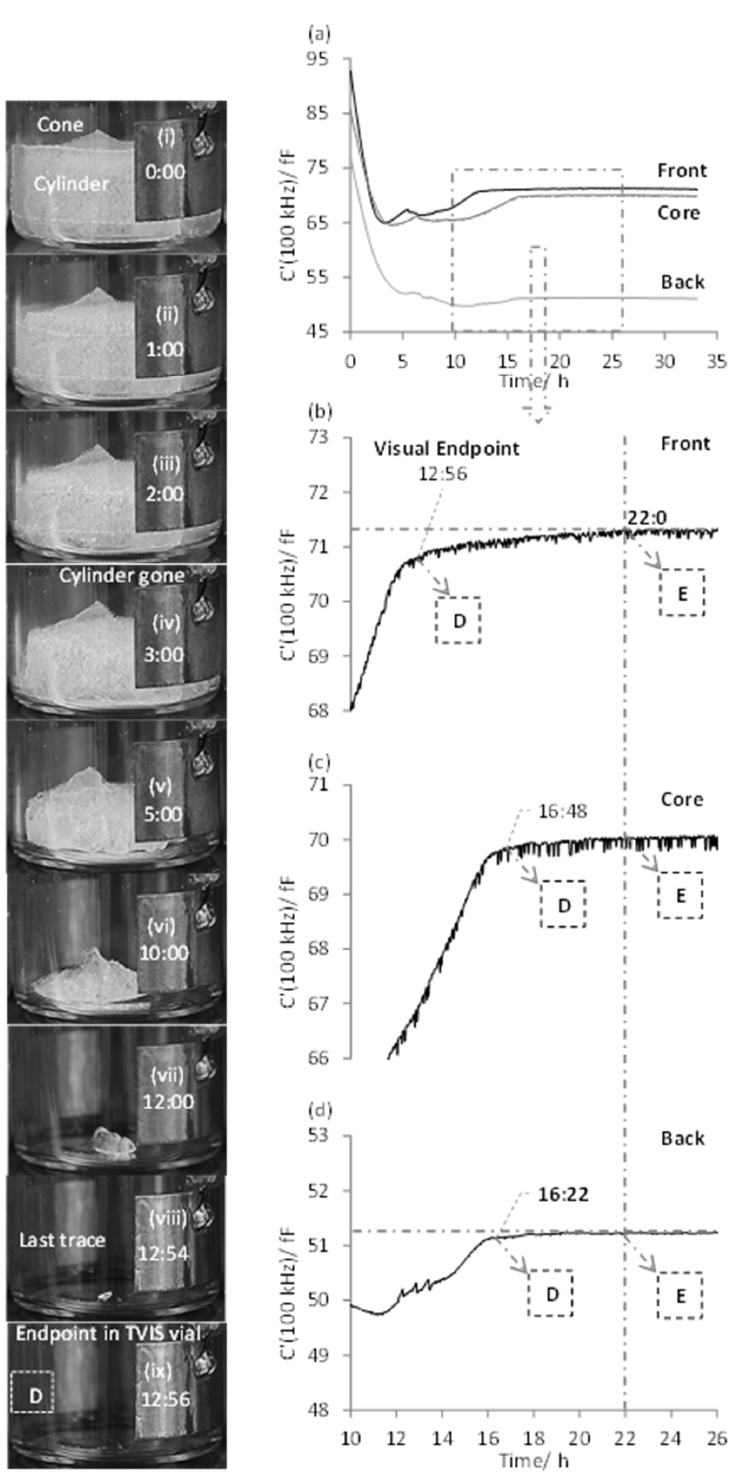
Figure 6. Determination of visual endpoint in the front edge TVIS vial and using this information to estimate the primary drying endpoint for the internal TVIS vials and therefore the batch endpoint: ( a ) an overlay of the time dependencies of C (cid:48) ( 100 kHz ) for the front, core and back TVIS vials; ( b – d ) time-lines of C (cid:48) ( 100 kHz ) for each TVIS vial on an enlarged scale. To the left are the photographs ( i – ix ) of the sublimation front obtained at various time-points during primary drying. The first inflection in the trajectory for the front TVIS vial corresponds to the visual endpoint (photograph ix at 12:56) and the second inflection at 22:00 occurs when all the TVIS vials reach